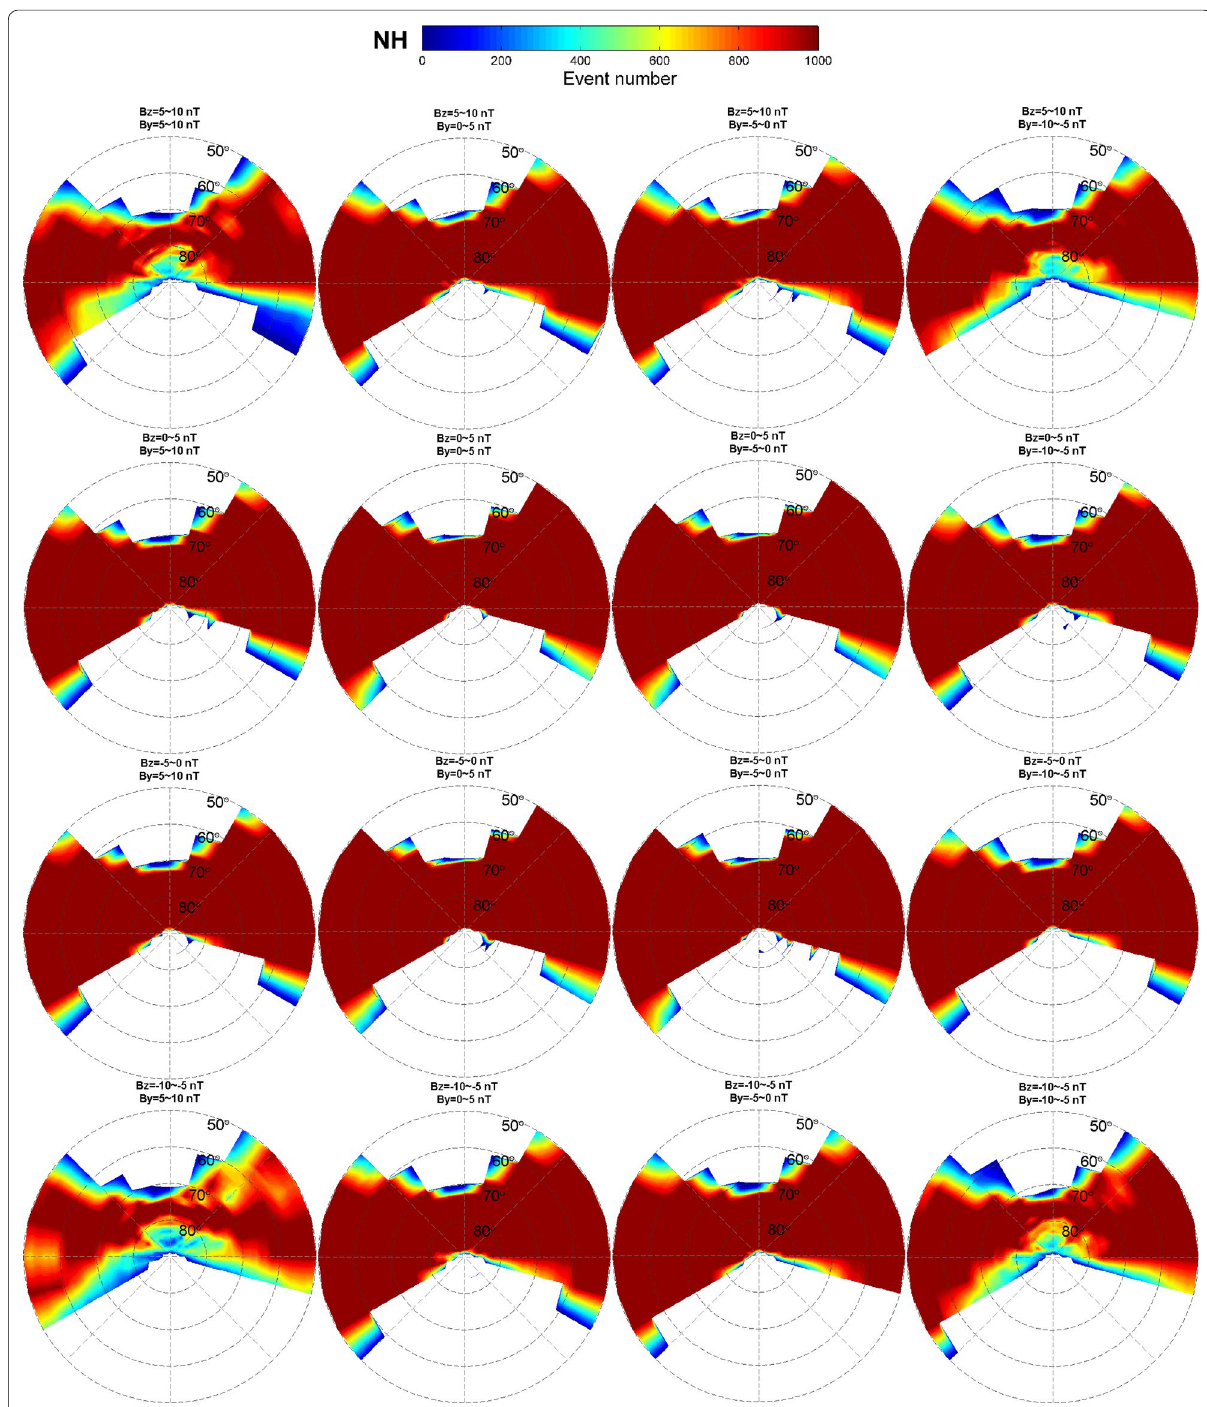
Fig. 10 a The data coverage of DMSP orbits in the northern hemisphere under different IMF conditions. For most of the bins, effective data point number is over 1000. b As similar as a but for the DMSP data coverage in the southern